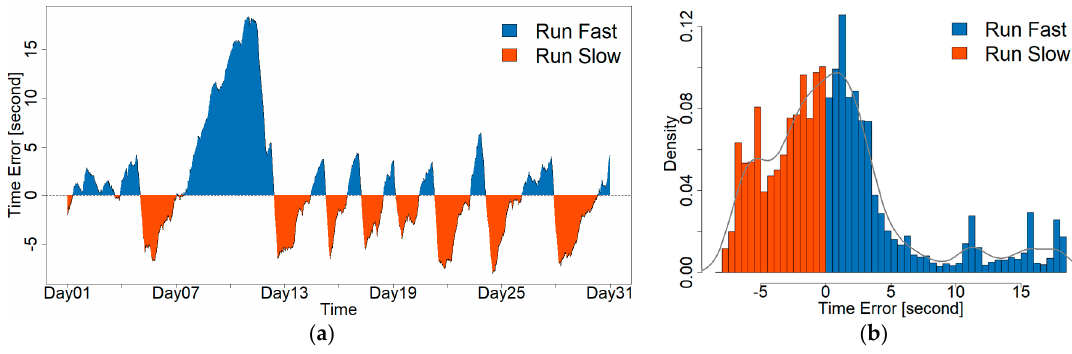
Figure 3. Time error change over one month in Eastern Interconnection (EI) system of North America. ( a ) Time-series curve of time error in October 2016; ( b ) Probabilistic distribution function of time error in one month. The blue color presents the fast time error. The orange color indicates the slow time error. The grey line shows the estimated probability density of time error.